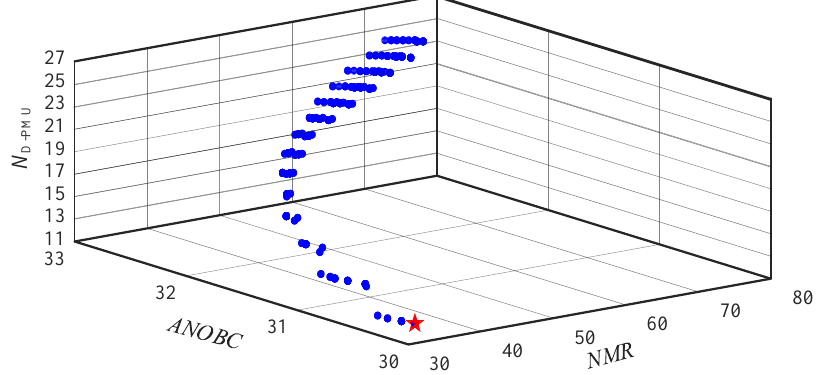
Figure 4. The Pareto set and the compromised optimal solution.